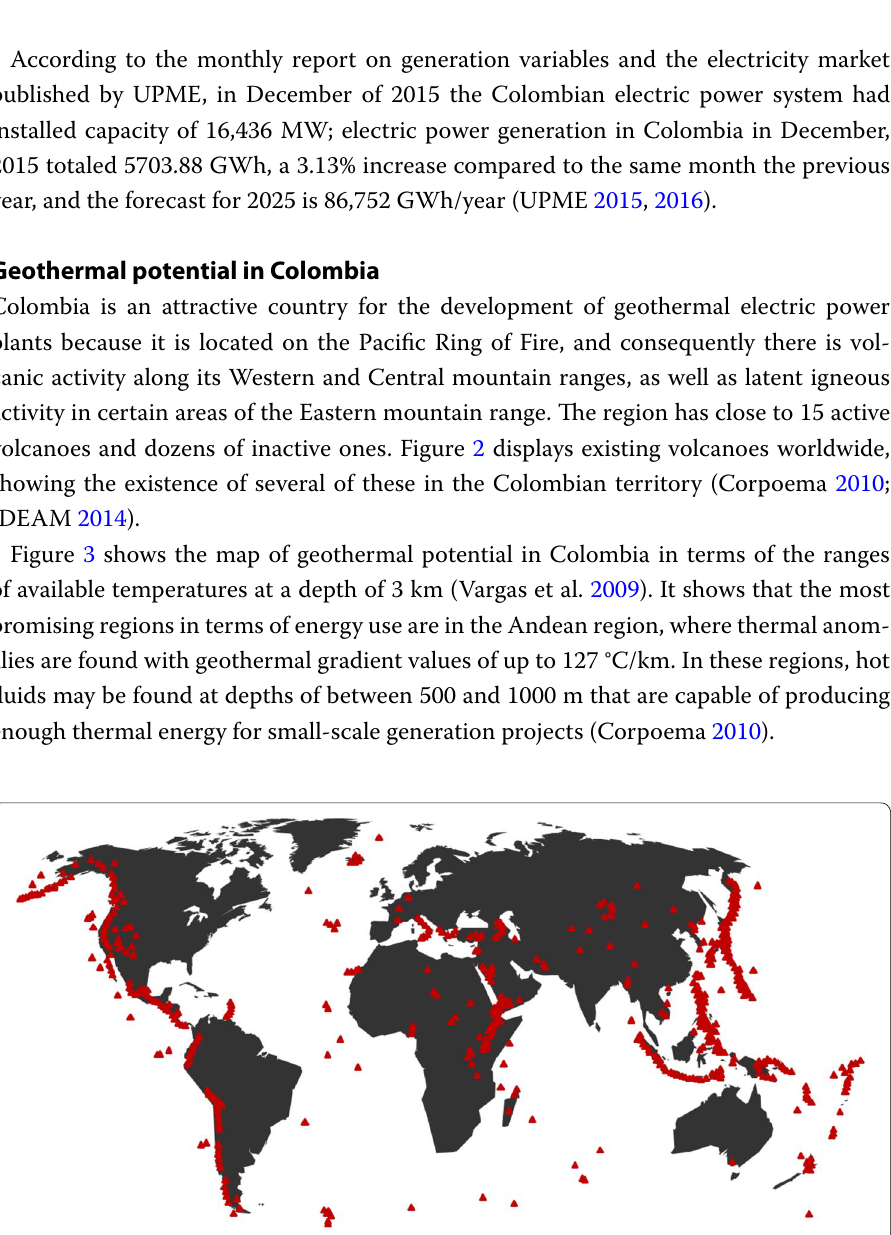
Fig. 2 Map of volcanoes in the